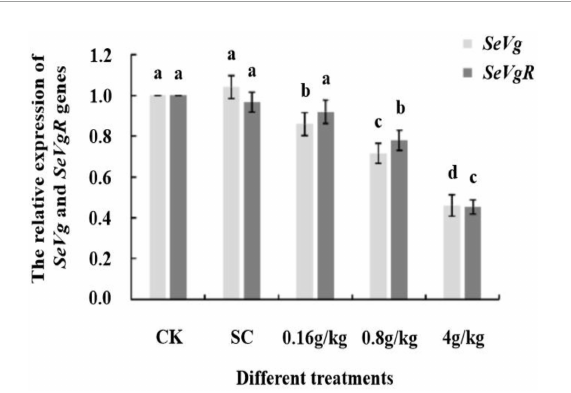
FIGURE4 The relative expression of SeVg and SeVgR genes in female adults of S. exigua after E β F treatments at different doses. CK (blank control) and SC (solvent control) were set as controls. The concentrations of E β F treatments were set as 0.16, 0.8, and 4 g/kg; the units of g/kg in all treatment groups means the mass ratio of E β F/artificial diet. Different lower-case letters indicated a significant difference determined by performing ANOVA, followed by Tukey’s HSD test ( p <